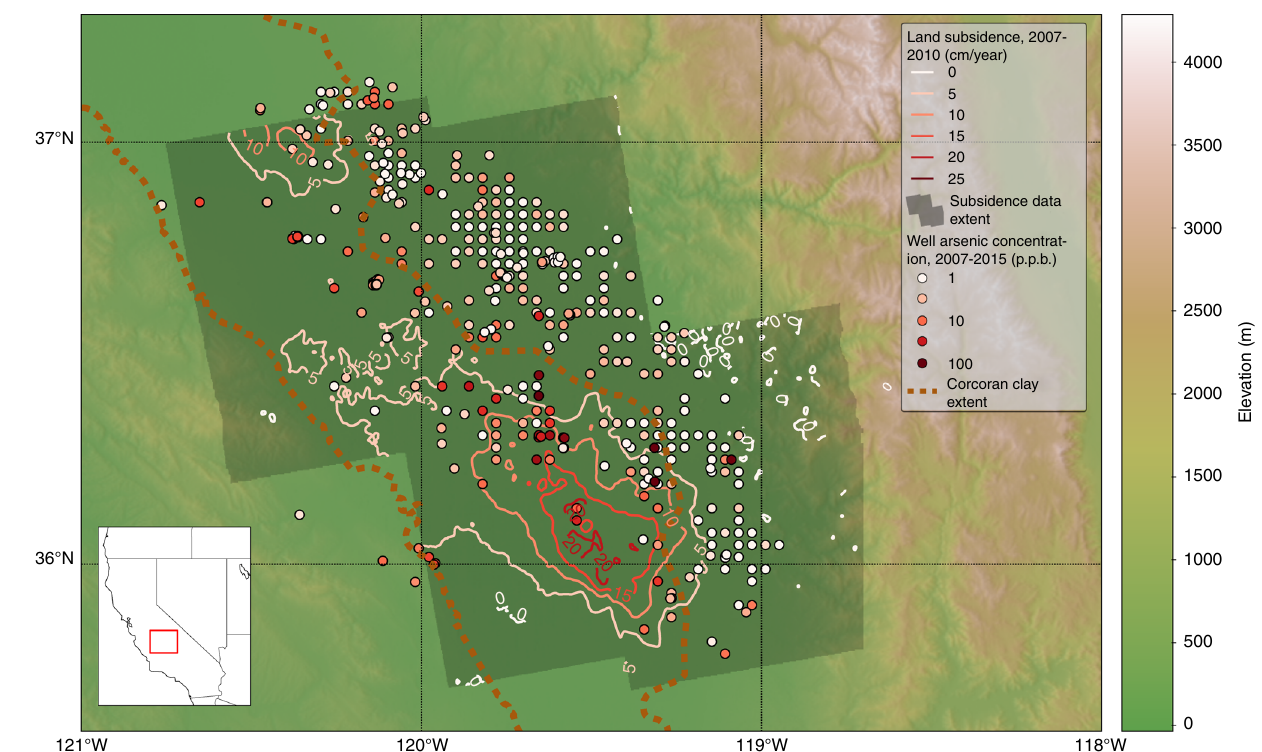
Fig. 1 Comparison of subsidence, arsenic concentration, and clay extent within the San Joaquin Valley, CA. Arsenic concentrations increase toward the center of the valley where subsidence is more extensive and a con fi ning clay layer (known as the Corcoran clay) is present 12 . The grayed-out region is the area where recent subsidence data (obtained from InSAR) were processed. Arsenic concentrations vary by orders of magnitude and are thus shown with a logarithmic color bar (see Supplementary Fig. 8 for arsenic concentration histograms). The arsenic concentration data points were sourced from 17 . The basemap was created using elevation data from the Shuttle Radar Topography Mission